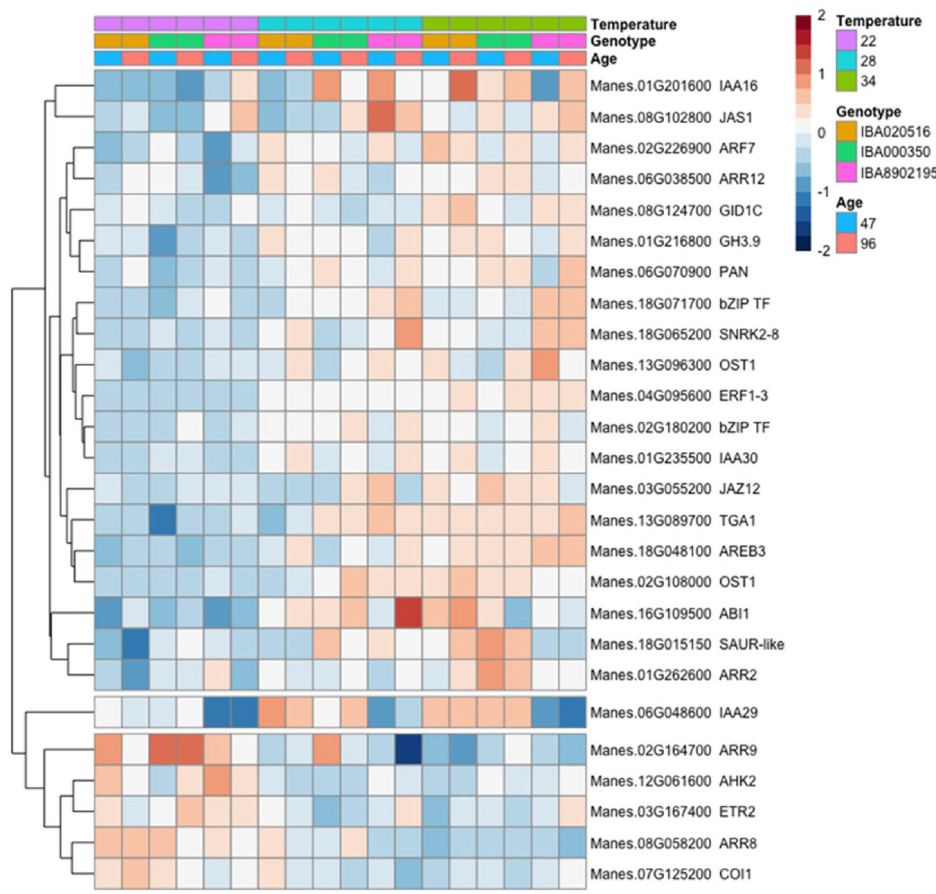
Fig 12. Relative expression (log 2 scale) of differentially expressed hormone signaling genes in response to controlled-environment temperature (22, 28 or 34˚C), genotype (‘516, ‘350, ‘2195), and timepoint of development (47 and 96 DAP). Each gene is identified by its Manihot esculenta number (Manes) and its closest Arabidopsis homolog. Color scale indicates log 2 fold changes. Legend in header indicates color coding of variables.